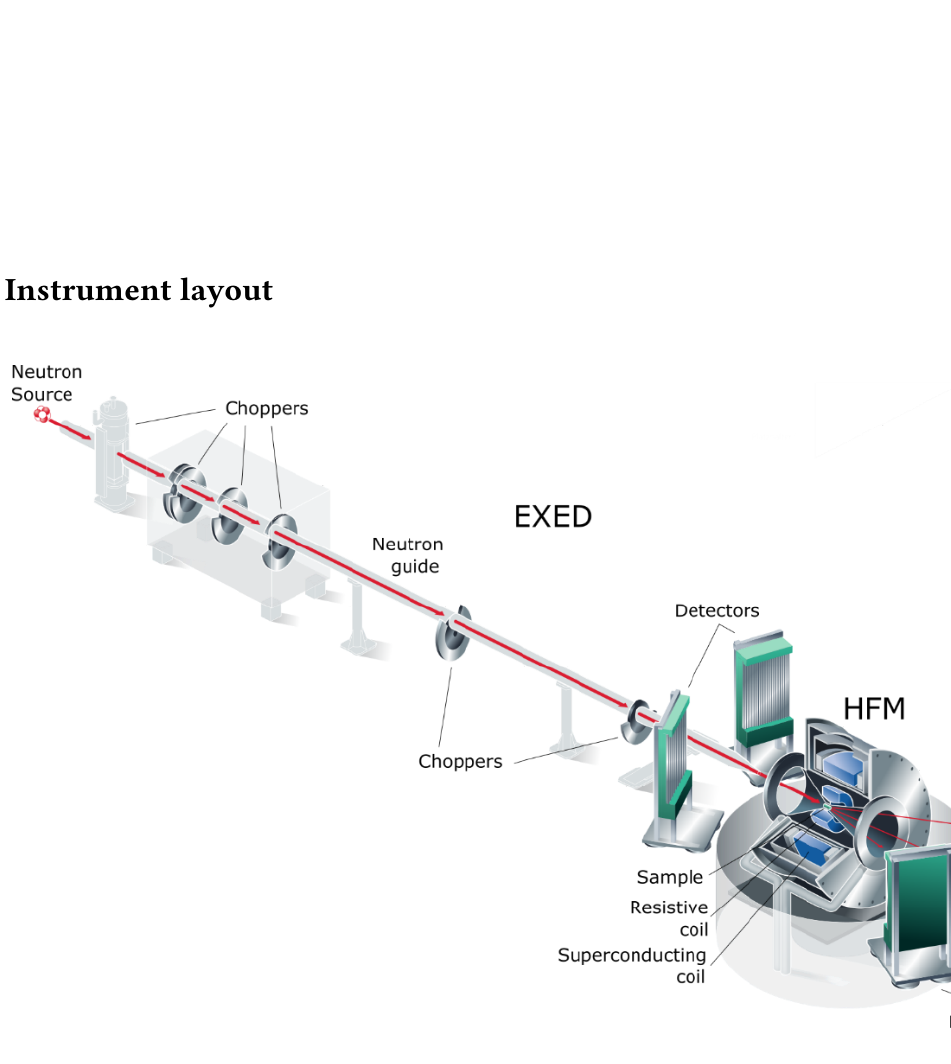
Figure 3: Schematic view of